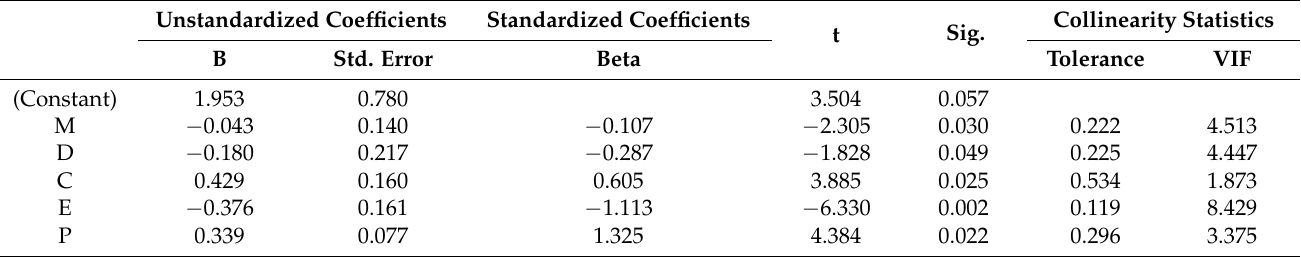
Table 6. Regression